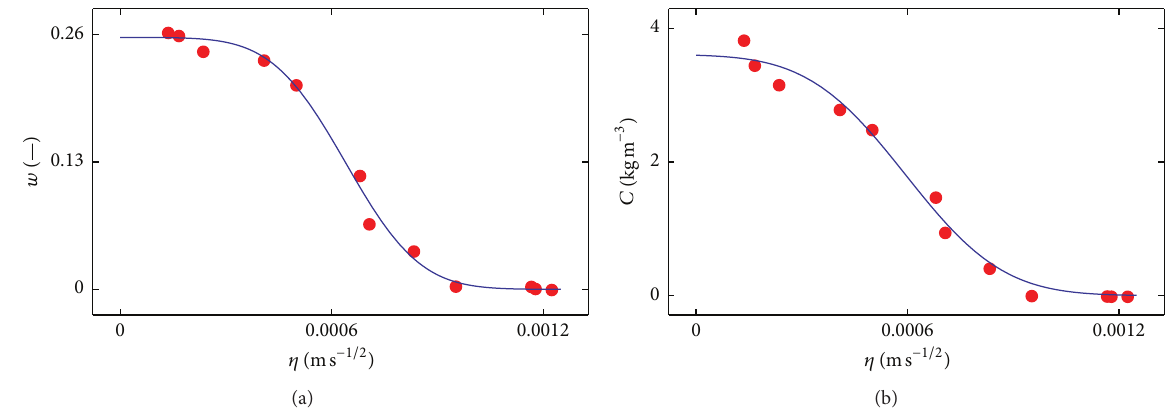
Figure 2: The profile of (a) the moisture content and (b) the total chloride concentration obtained experimentally (disks) and their approximations by the erfc model profiles (curves), as adapted from [9].